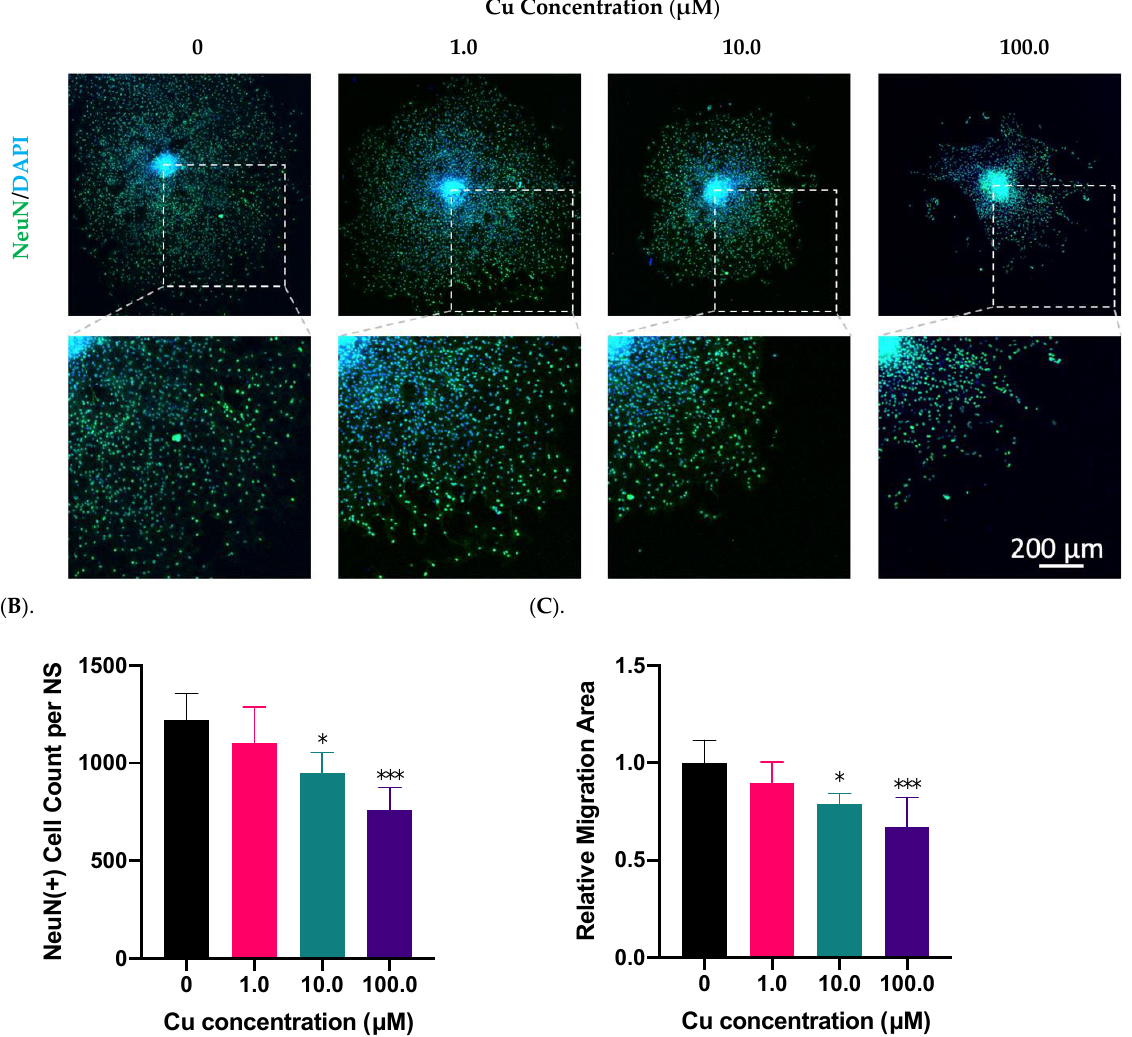
Figure 2. Cu dose-dependent suppression of neurosphere growth in vitro. ( A ). Differentiation and migration of SVZ neurospheres in response to Cu exposure in the culture medium at 1.0, 10.0, and 100.0 µ M Cu. Differentiated mature neurons were labeled with NeuN. Scale bar = 200 µ m. ( B ). NeuN(+) mature neurons per neurosphere (NS) were quantified in each group. Data represent mean ± SD, n = 6; * p < 0.05, *** p < 0.001 as compared with controls. ( C ). The relative migration area of neurospheres was quantified and normalized to the controls. Data represent mean ± SD, n = 6; * p < 0.05, *** p < 0.001 as compared with controls.